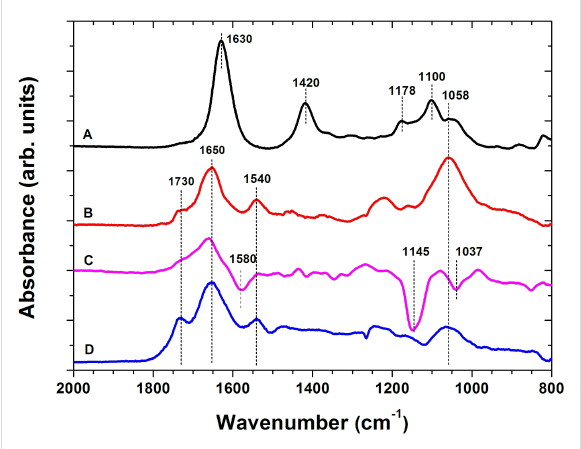
Figure 5: Differential IRRAS spectra of free alginate adsorbed onto a flat titanium surface (A) and covalently bound alginate molecules to the amines of the neridronate (B), APTES (C) and PDA (D) anchor layers. The IRRAS spectra of covalently bound alginate films was character- ized by the presence of the carbonyl band (1730 cm − 1 ), amide I (1650 cm − 1 ), amide II band (1540 cm − 1 ) and ν (C–O) stretching modes of the pyranosyl ring, β -(1-4)-glycosidic bonds and hydroxy groups of the polysaccharide (1200–1000 cm − 1 ). The spectra were referenced to corresponding background spectra of bare titanium and titanium bearing different anchor layers.